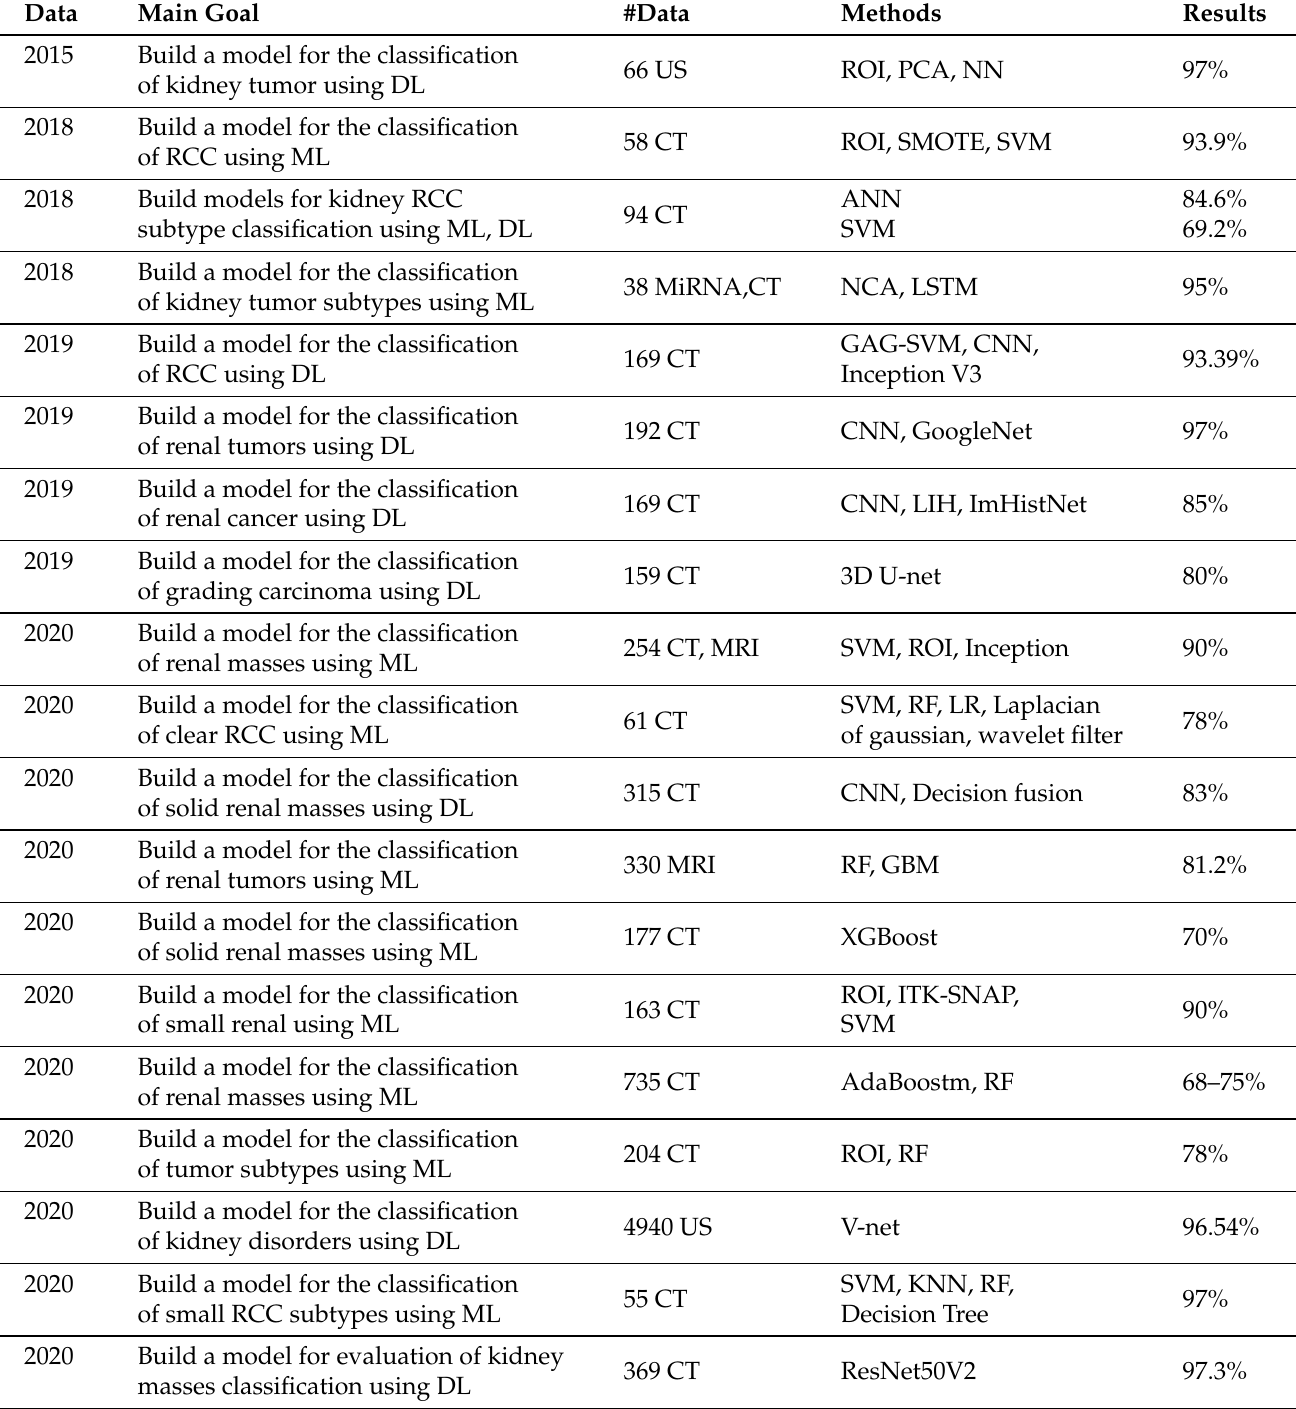
Table 4. The outcomes of the related classification tumor